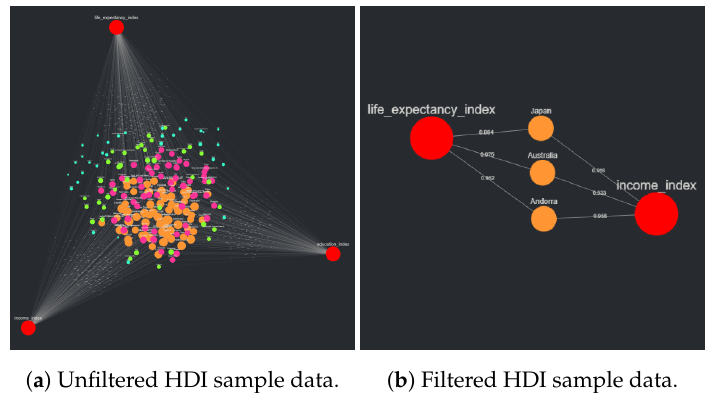
Figure 12. The HDI sample data, both unfiltered ( a ) and filtered ( b ), based on criteria described in Section 2.3.2.